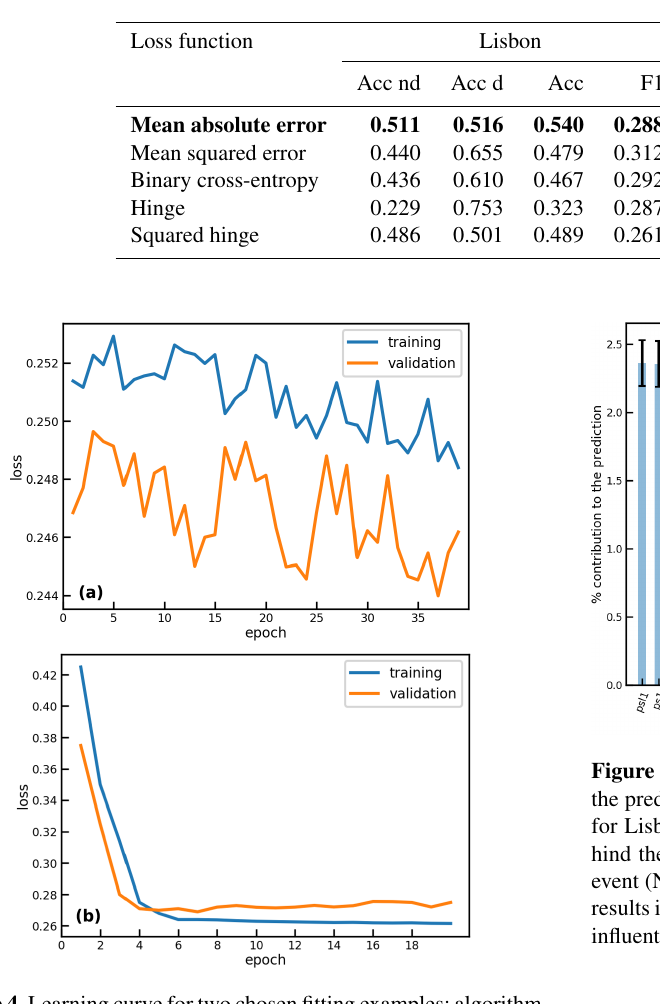
Figure 4. Learning curve for two chosen fitting examples: algorithm complexity insufficient (a) and overfitting (b) .